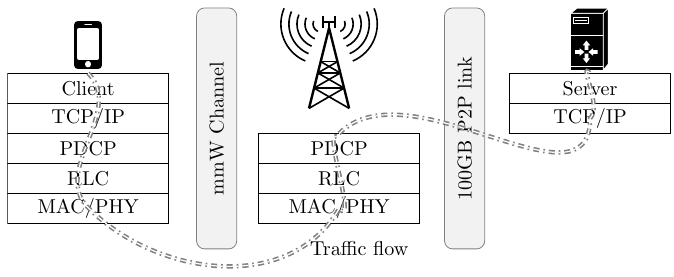
Figure 1. General description of the scenario under